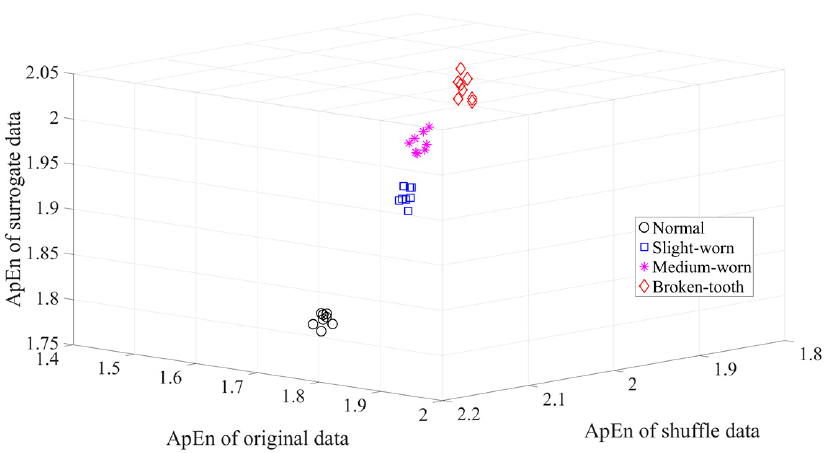
Figure 12. Ternary ApEn of the gear vibration data.